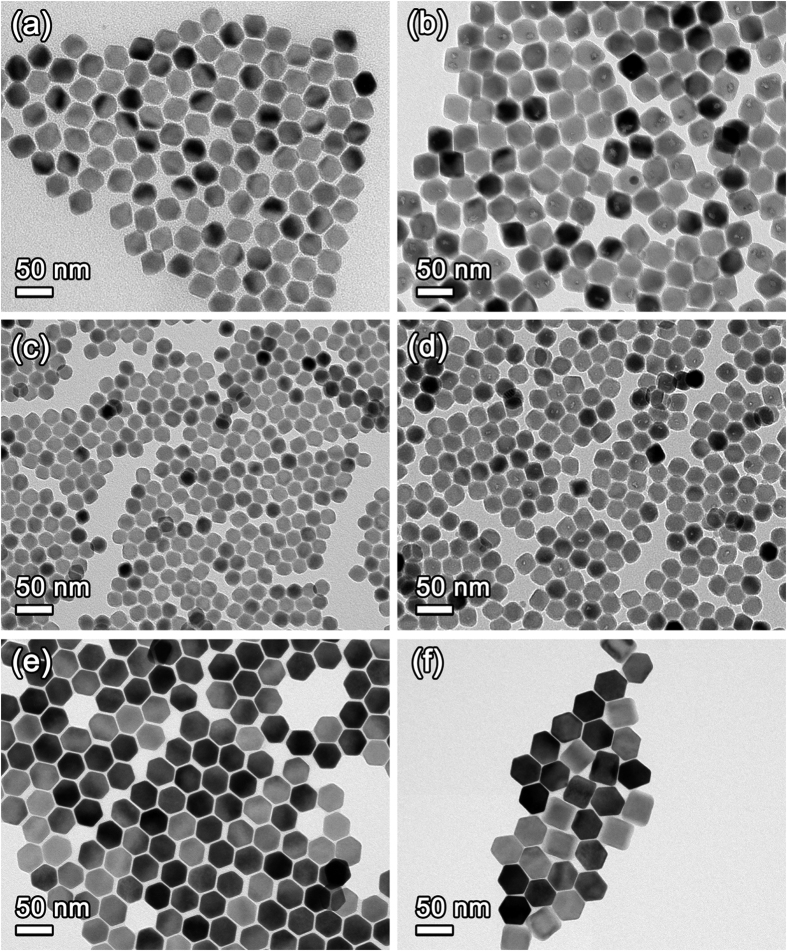
TEM images of (a) Li(Gd,Y)F4:Yb,Er, (b) Li(Gd,Y)F4:Yb,Er/LiYF4, (c) Li(Gd,Y)F4:Yb,Tm, (d) Li(Gd,Y)F4:Yb,Tm/LiYF4, (e) NaGdF4:Yb,Tm, and (f) NaGdF4:Yb,Tm/NaGdF4:Eu UCNPs.